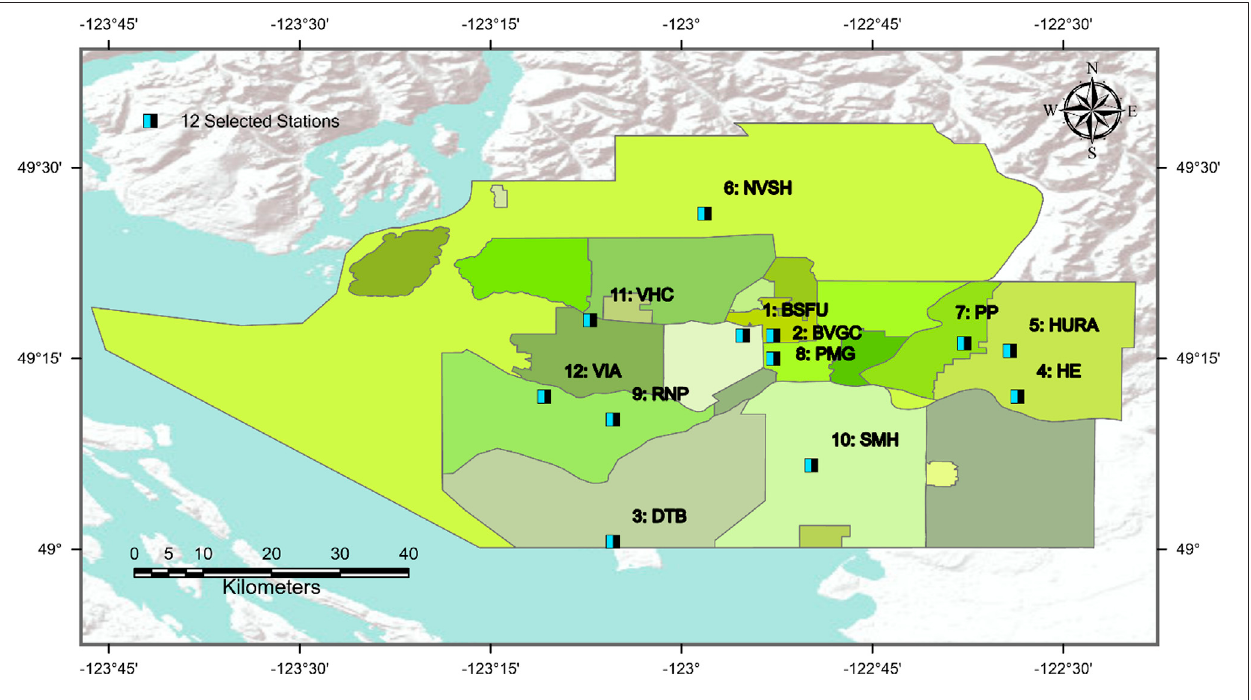
FIGURE 1 | The spatial distribution of 12 selected meteorological stations.